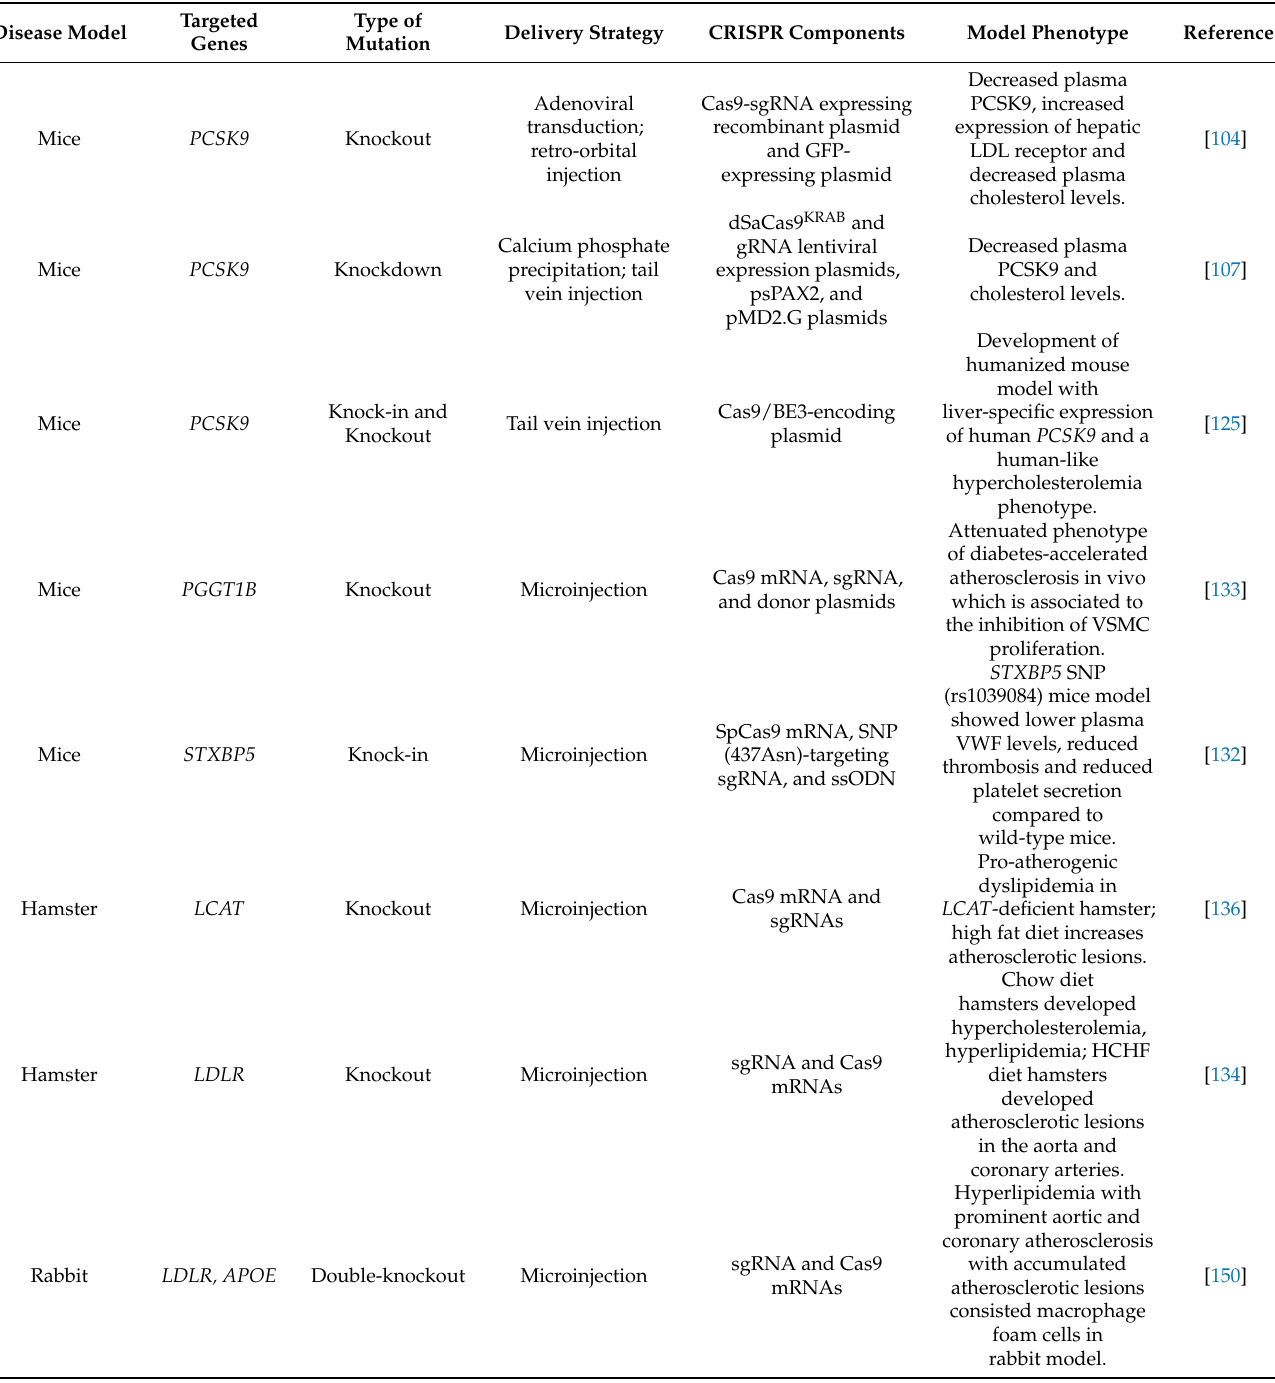
Table 2. CRISPR/Cas9 genome editing in atherosclerosis models (in